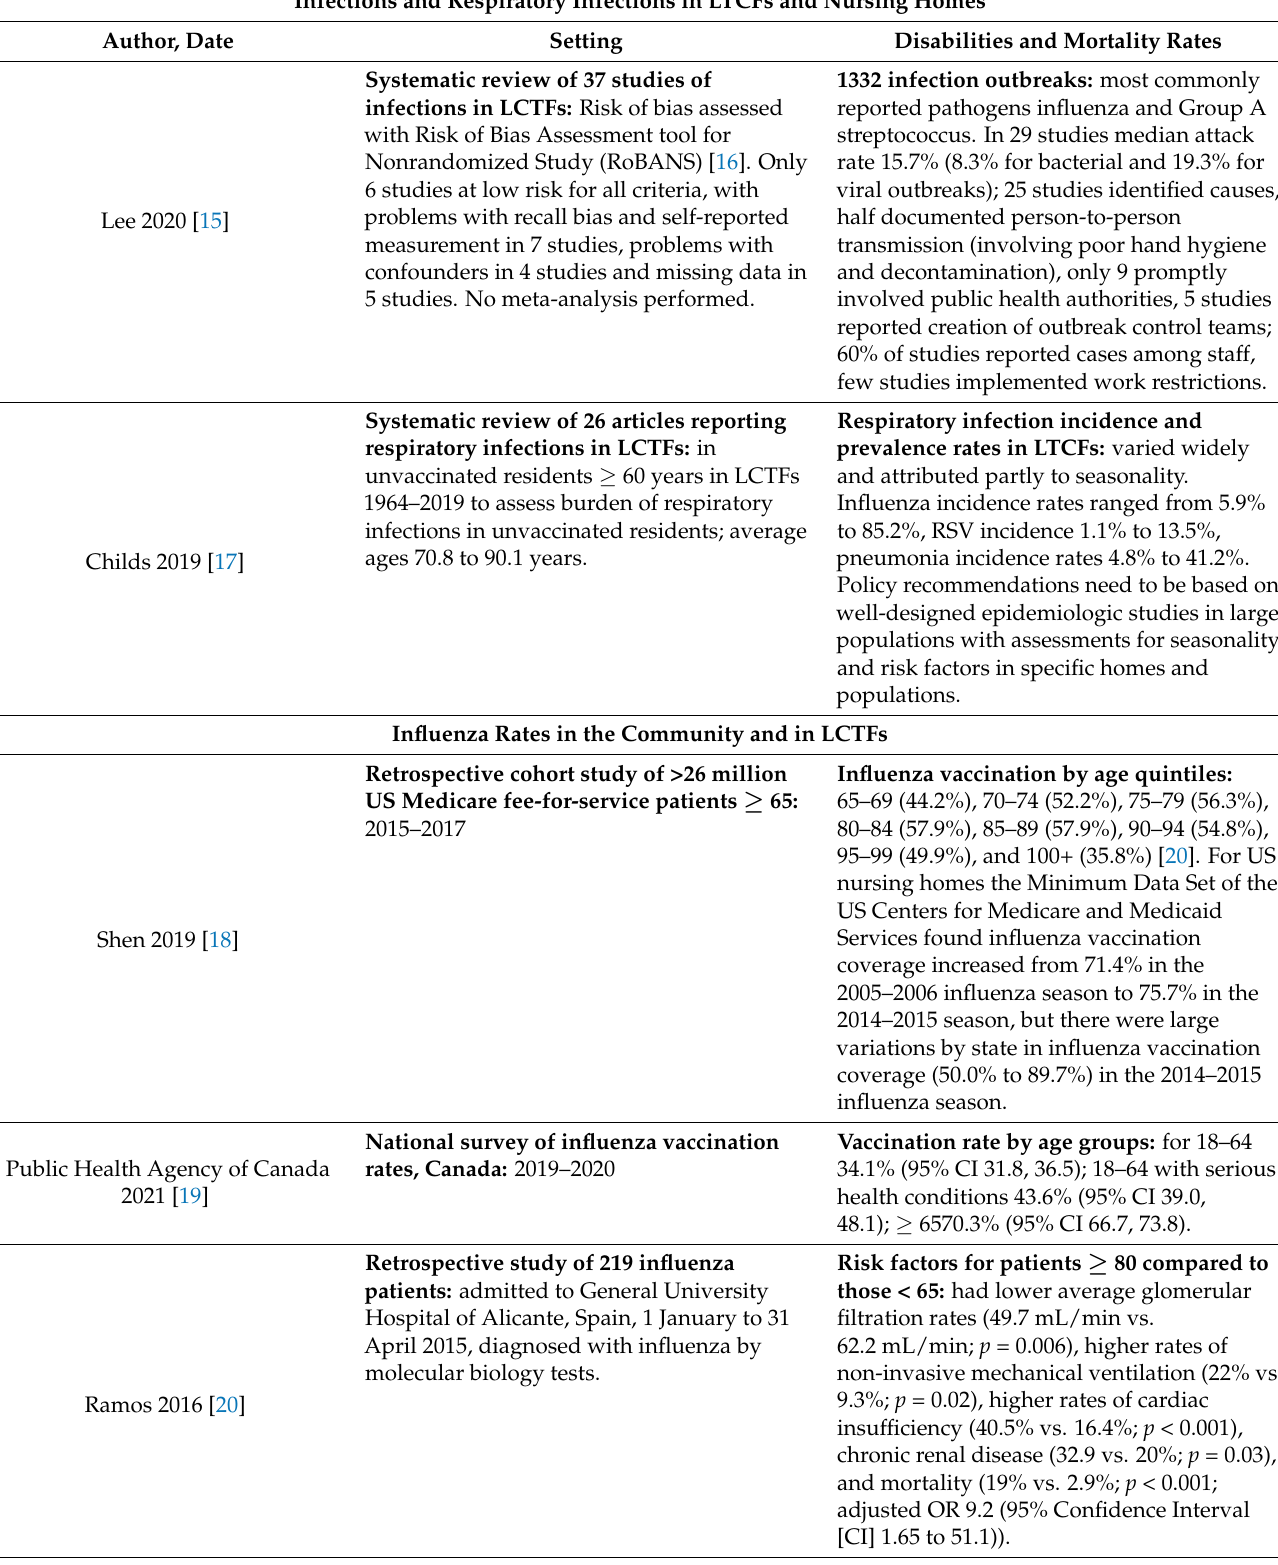
Table 4. Respiratory infections in nursing homes and